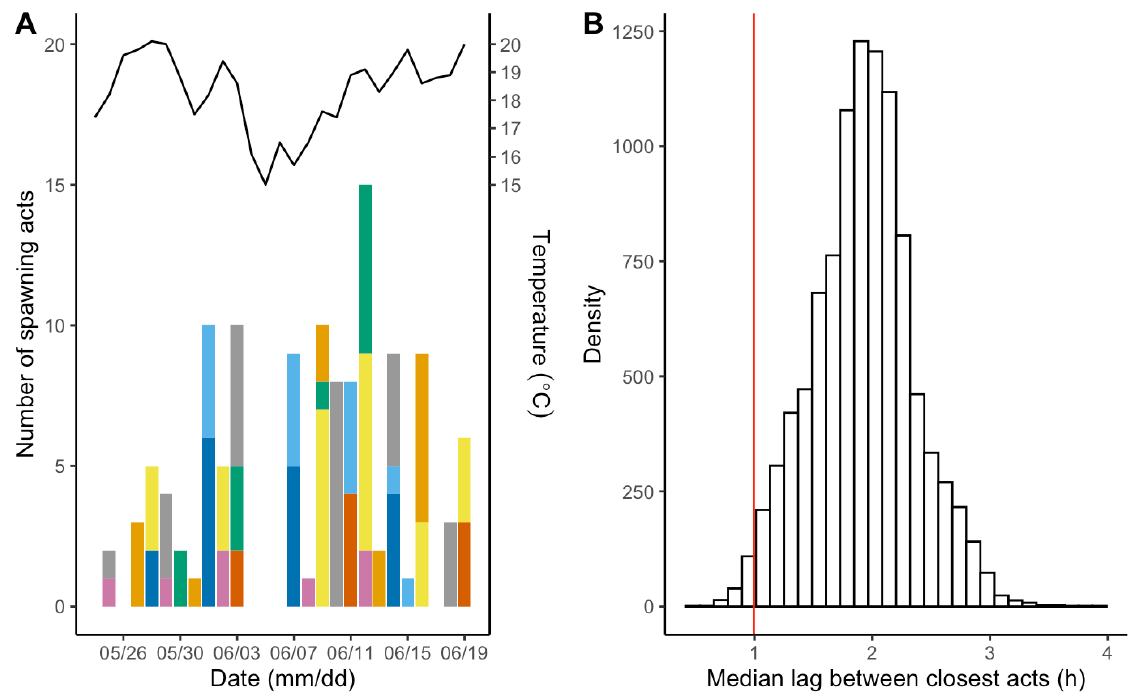
Figure 3. The temporal distribution of spawning acts by eight Allis shad females in the river Nivelle in spring 2017. A. Cumulated number of spawning acts for each night of the season. Each colour corresponds to an individual. The line above the bar plot represents the average water temperature measured each night between 10PM and 7AM. B. Synchrony of spawning acts performed by different females within a night (only the first act of the night, for each female). The red vertical line represents the median time lag between nearest spawning acts for observed data. The histogram represents the same thing for 10 000 permutation of the hour of the